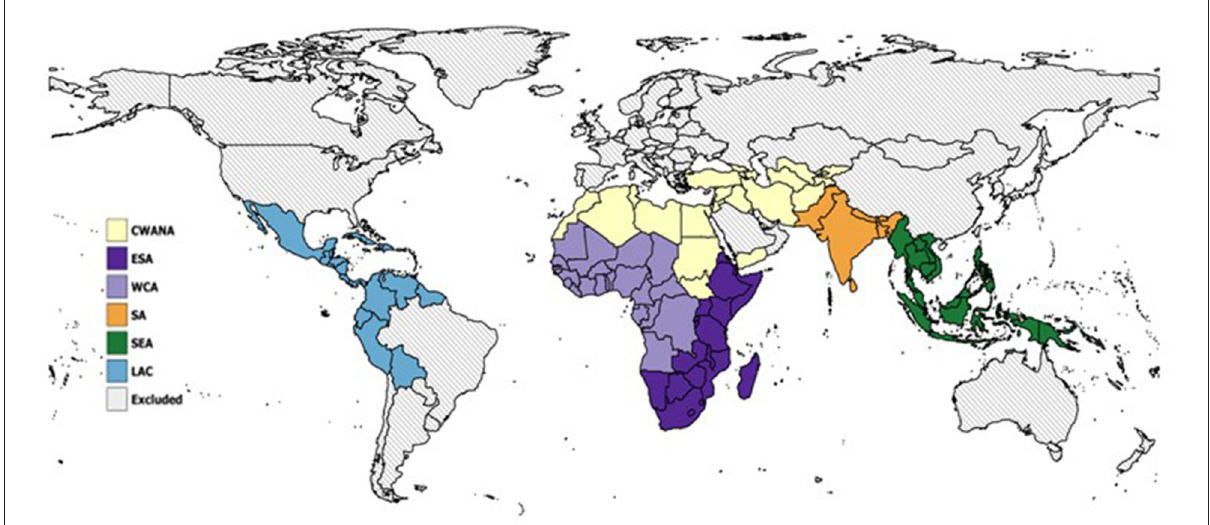
FIGURE1 Global map showing countries and regions of interest. LAC, Latin America & Caribbean; CWANA, Central, West Asia & North Africa; WCA, Western & Central Africa; ESA, Eastern & Southern Africa; S Asia, South Asia; SE Asia, Southeast Asia & Pacific. The gray-hatched areas are excluded from the quantitative assessment but are part of the simulation framework as documented in Robinson et al. (2015). For some measures, ESA and WCA countries are grouped together into sub Saharan Africa